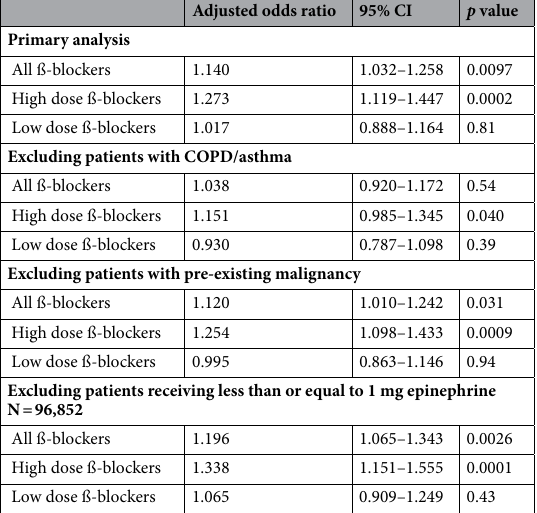
Table 5. Sensitivity analysis of the logistic regression model for one-year survival outcomes in cardiac arrest patients with non-shockable